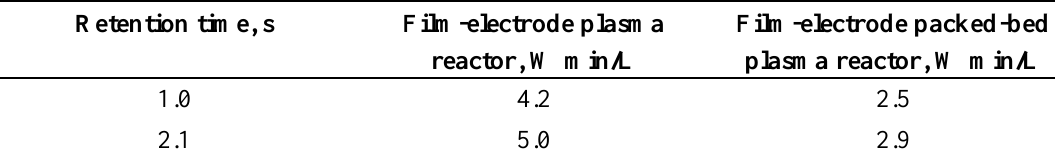
Table 1. Comparison of specific